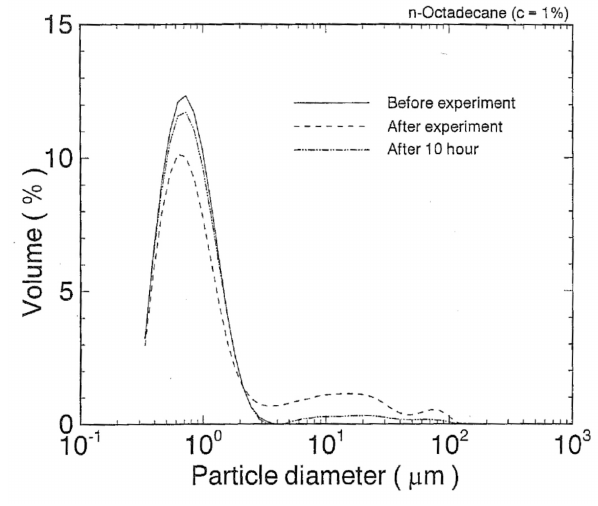
Figure 5. Effect of thermal cycles on the suspension particle